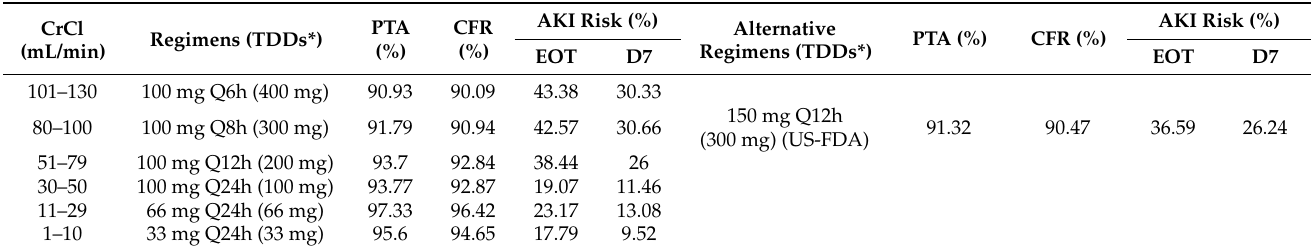
Table 5. Recommendation for MIC of 0.5 mg/L (MIC 90 of our hospital).